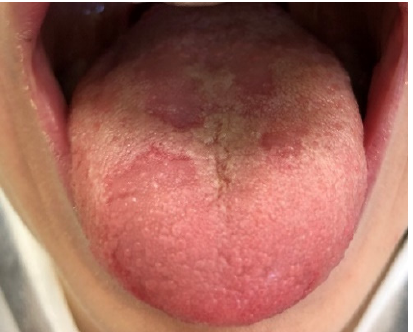
Figure 8. Geographic tongue ( Migratory glossitis ) in an 11-year-old boy. Characteristic, well-demarcated zones of erythema (atrophy of the filiform papillae) on the dorsal tongue mucosa, which may migrate over time to different sites of the tongue mucosa.